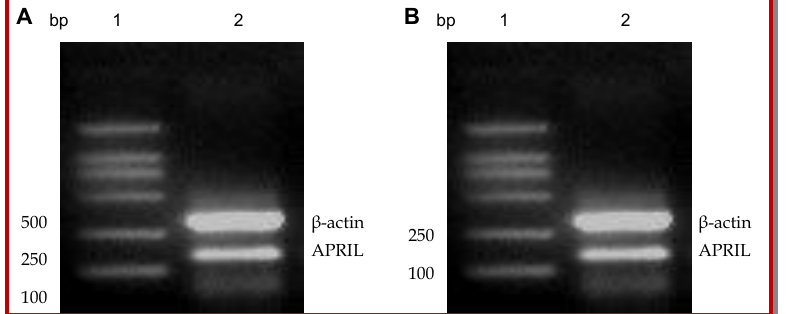
Figure 3: Expression of APRILmRNA A), HSPGmRNA (B) on HepG2 cells detected of RT-PCR. 1. Marker DL2000; 2. APRILmR- NA; 3.